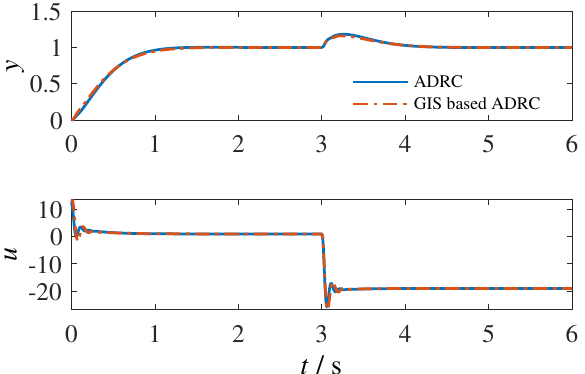
Figure 9. The curves of response y and control output u with a unit step of set-point and a centralized step disturbance for the Example 4 under ADRC and GIS-based